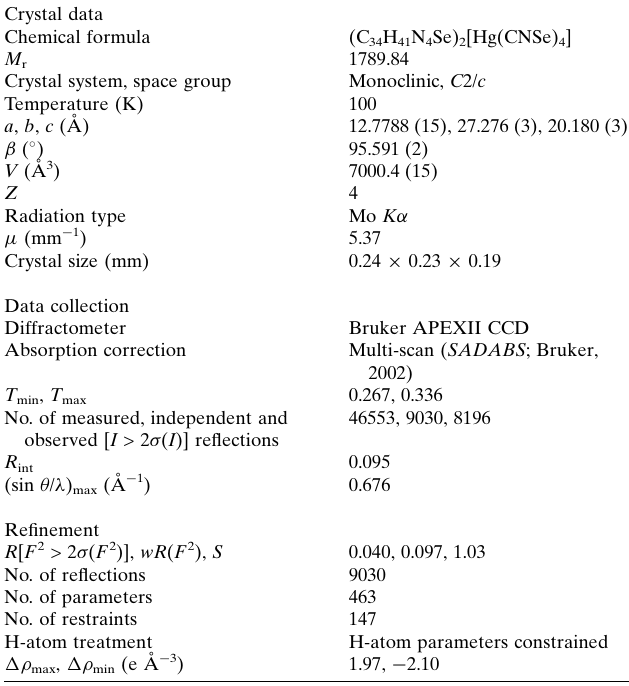
Table 2 Experimental details. Crystal data Chemical